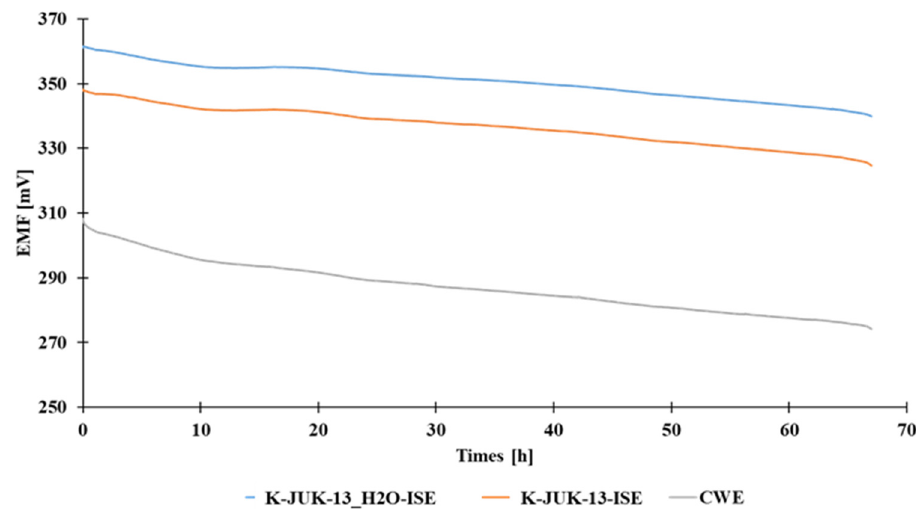
Figure 2. The change in potential of the tested electrodes with MOFs as ion-to-electron transducers and a coated wire electrode over time. The measurements were carried out in 10 − 2 mol L − 1 KCl.